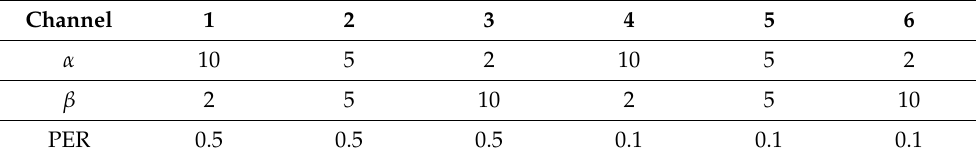
Table 2. Channel